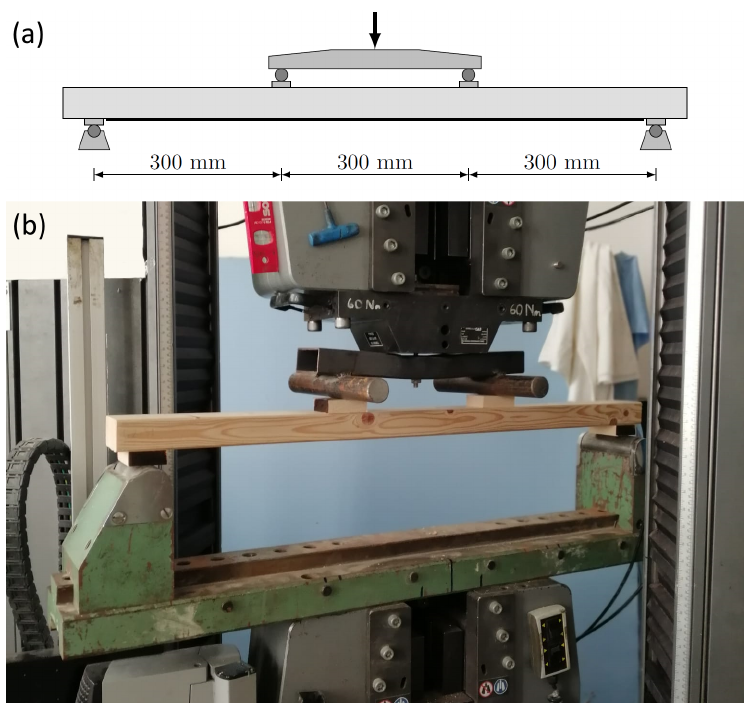
Figure 2. Bending test setup. ( a ) Sketch of loading arrangement; ( b ) testing machine.